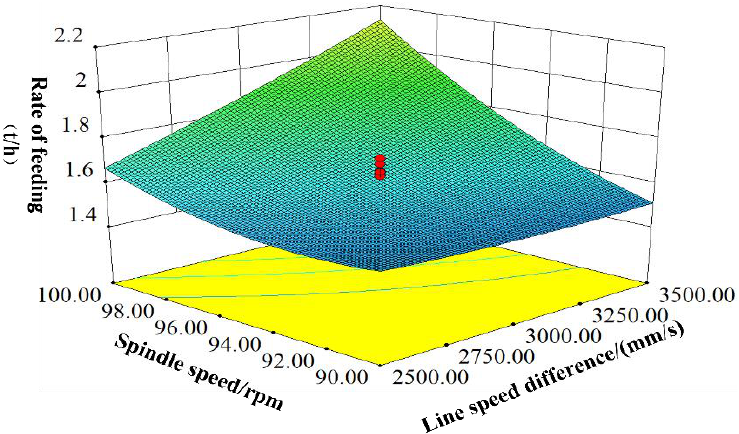
Figure 10. Influence of spindle speed and auxiliary roller diameter on feeding rate.